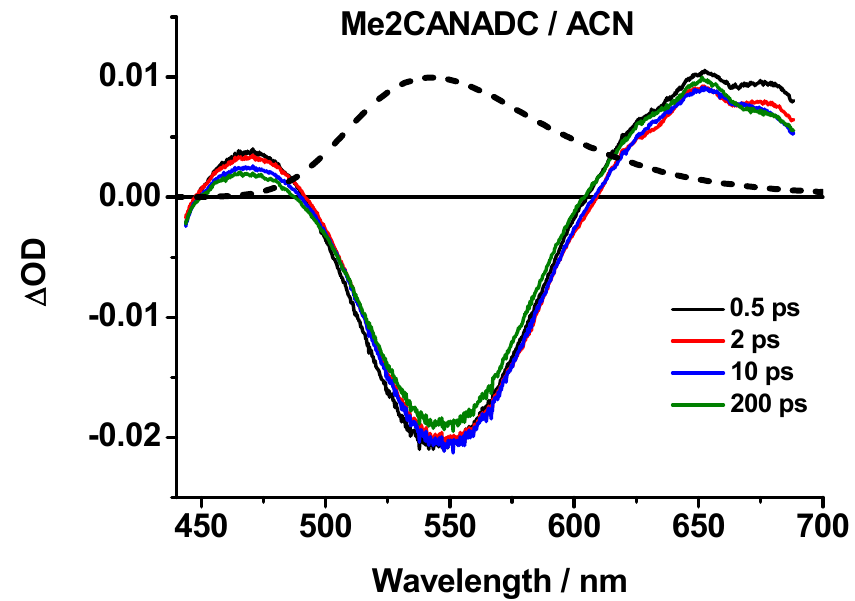
Figure 5. Femtosecond transient absorption spectra (TAS) of Me 2 CANADC in ACN solvent at different time delays upon excitation at 420 nm. The dashed spectrum corresponds to the steady-state emission one showing the good overlap with the negative TAS band.